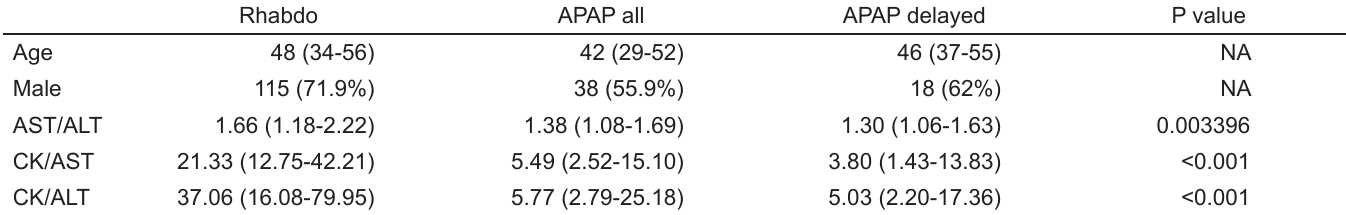
P values represent the results of the Kruskall-Wallis test of comparison between the rhabdomyolysis group and the acetaminophen (delayed)